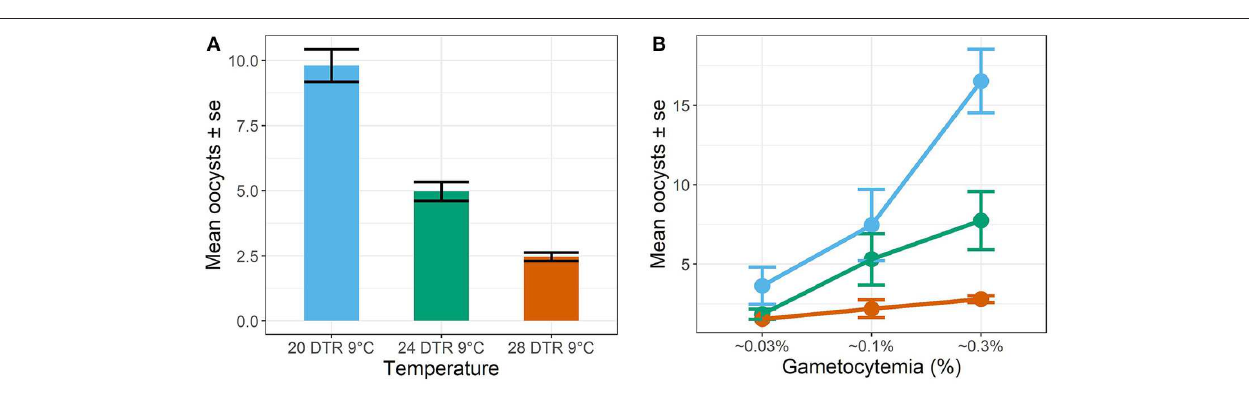
Frontiers in Microbiology |